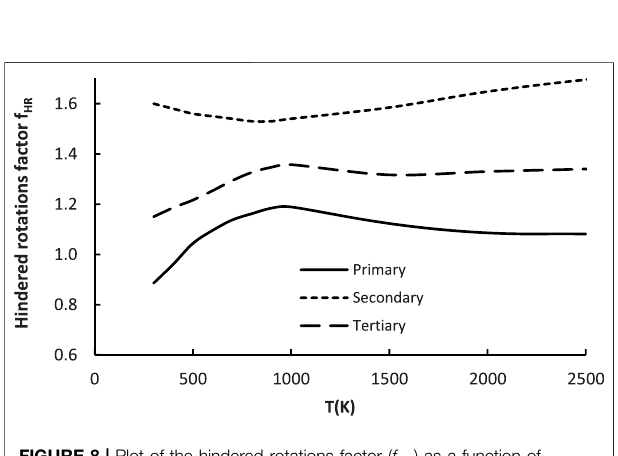
FIGURE 8 | Plot of the hindered rotations factor ( f HR ) as a function of temperature for all 23 reactions considered in the representative set (R 2 – R 24